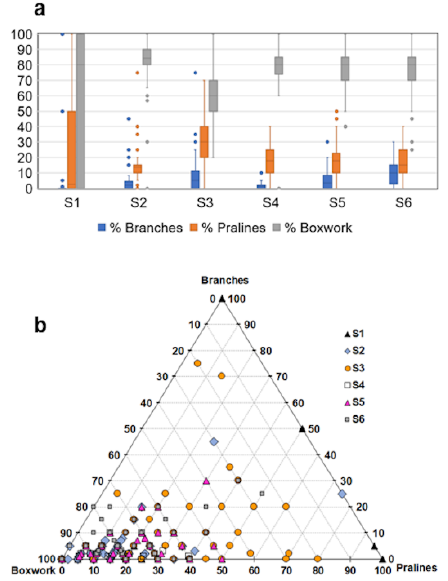
Figure 6. ( a ) Boxplot of three different morphotypes percentage in the sampling sites; ( b ) ternary plot of the three morphotypes (coverage in %) per sampling site.